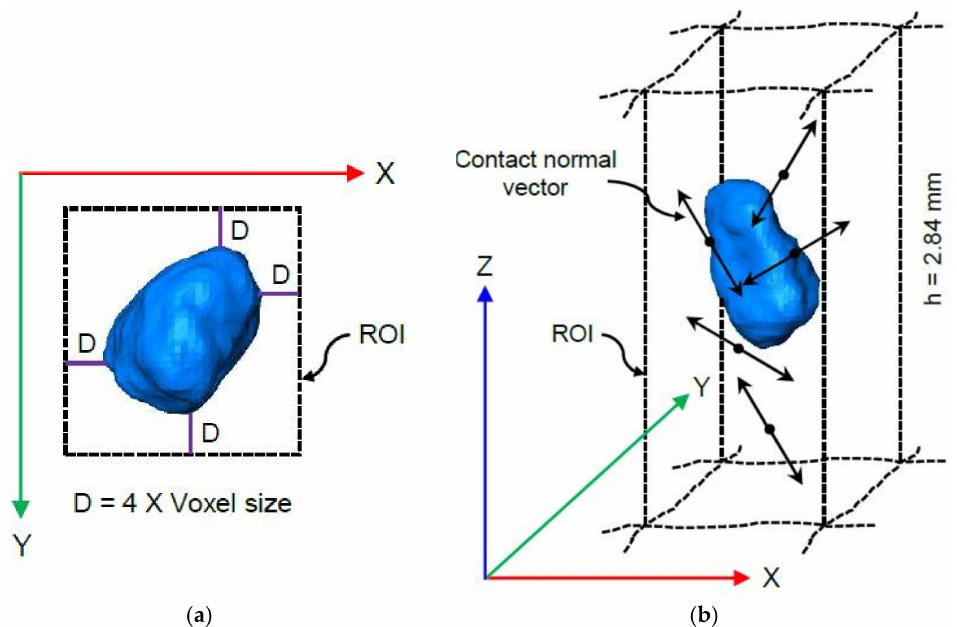
Figure 7. Finding contact normal vectors within a selected region of interest (ROI) around a particle: ( a ) XY view of a particle with the ROI; ( b ) 3D view of a particle with the contact normal vectors in the